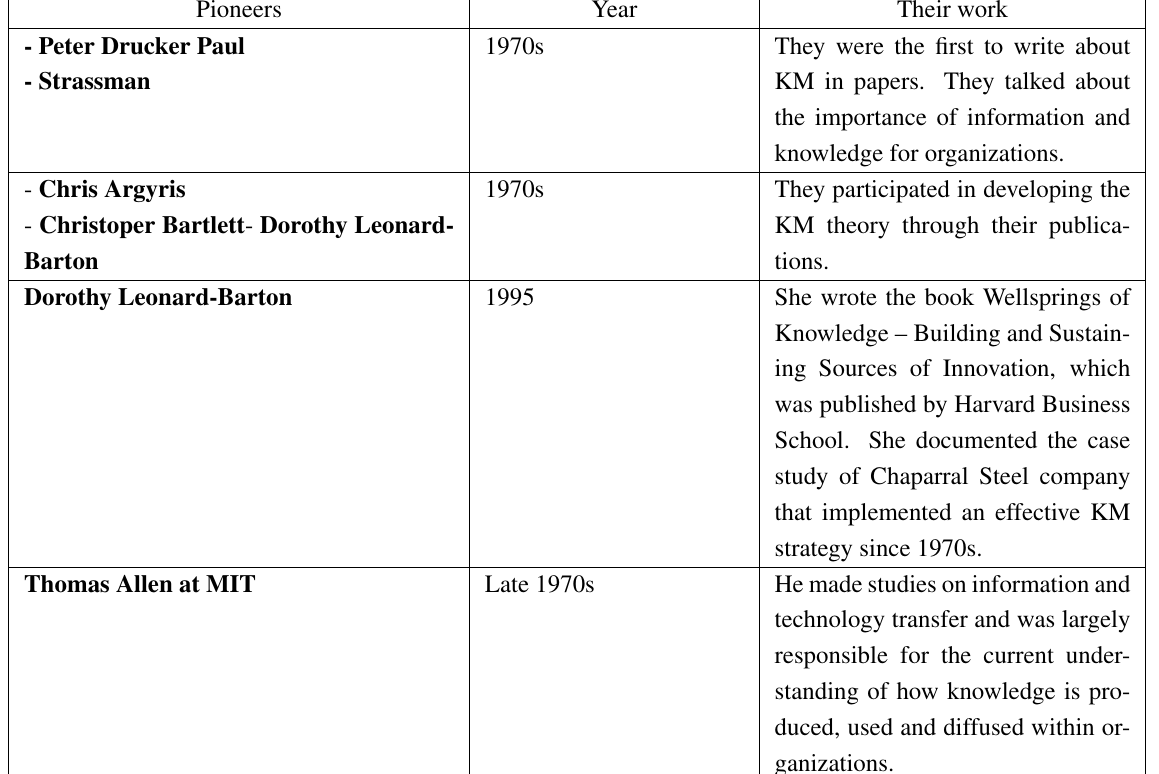
Table 1. Contribution of management theorists and experts (Uriarte,